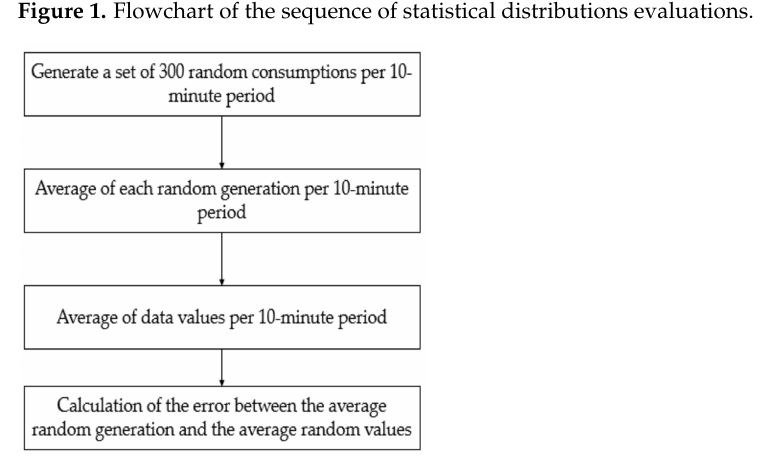
Figure 2. Flowchart of the comparison between random and real